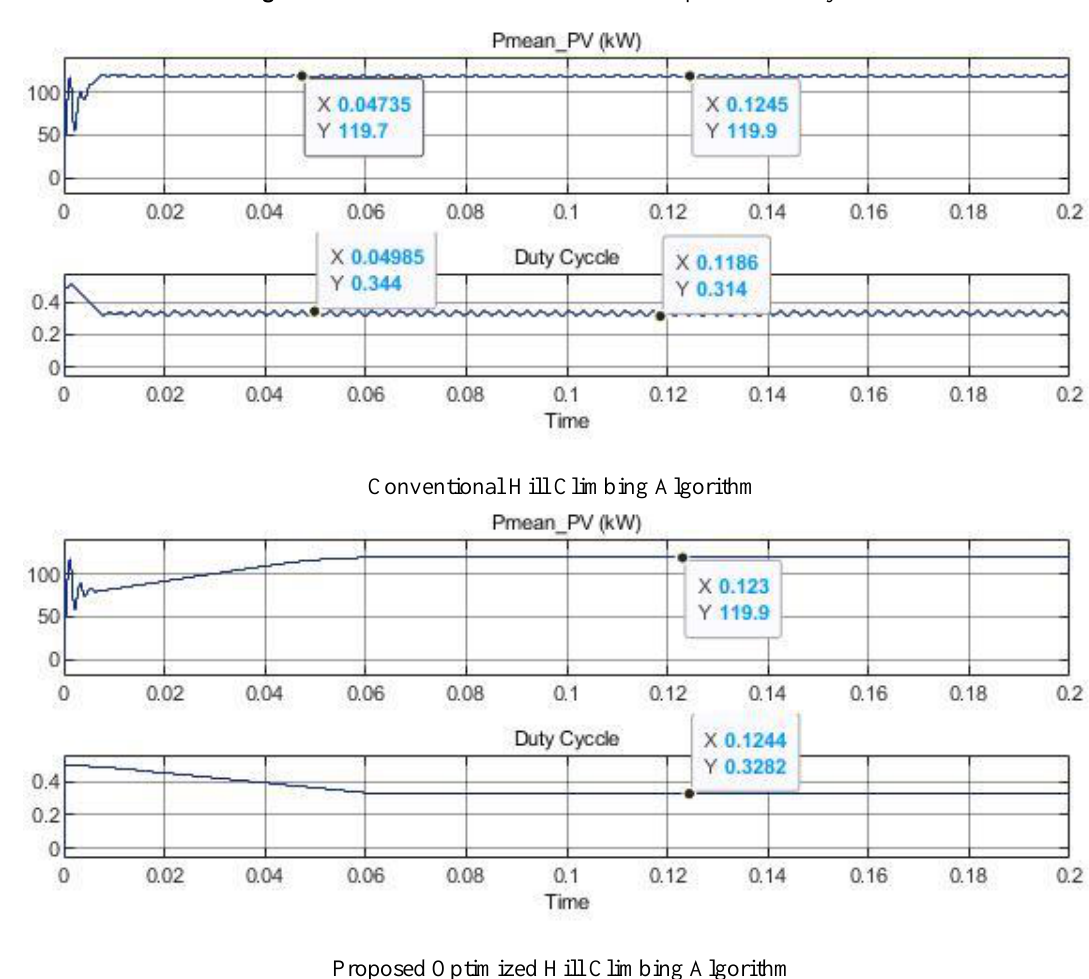
Fig. 5. Characteristic curve for a standalone photovoltaic system